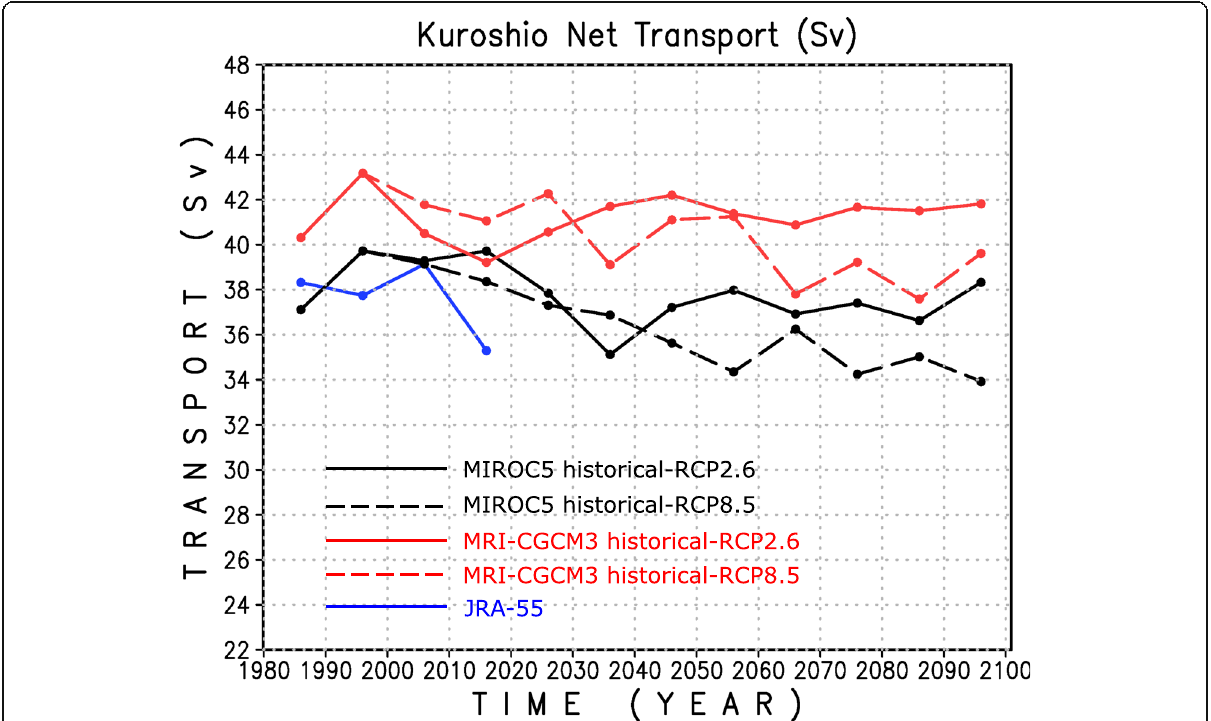
Fig. 6 Time series of the 10-year mean net Kuroshio transport (Sv), estimated from the transport stream function between (26° N, 140° E) and (34° N, 134° E) from the NP10 results. Note that the last value of JRA-55 is the 5-year (2011 – 2015) mean